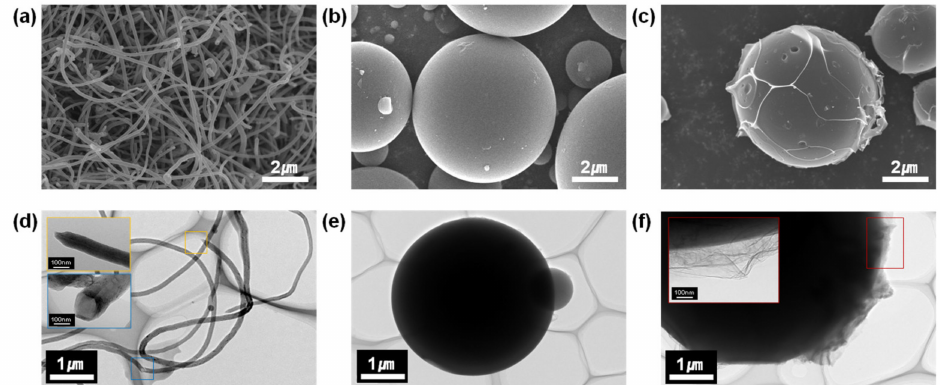
Figure 2. Morphologies and microstructures of ( a , d ) pure CNFs, ( b , e ) carbonized spherical phenol resin, and ( c , f ) hybrid porous carbon (HPC)-1/10. ( a , d ) Pure CNFs have an approximate diameter of 100 nm and length of 150 um, respectively; they exhibit nanocone-shaped tips (marked yellow box) and open snake head-like tips (marked blue box). ( b , e ) Pure spherical phenolic resins have a spherical morphology with non-uniform particle size. ( c , f ) HACs are well wrapped by ribbon-like carbon